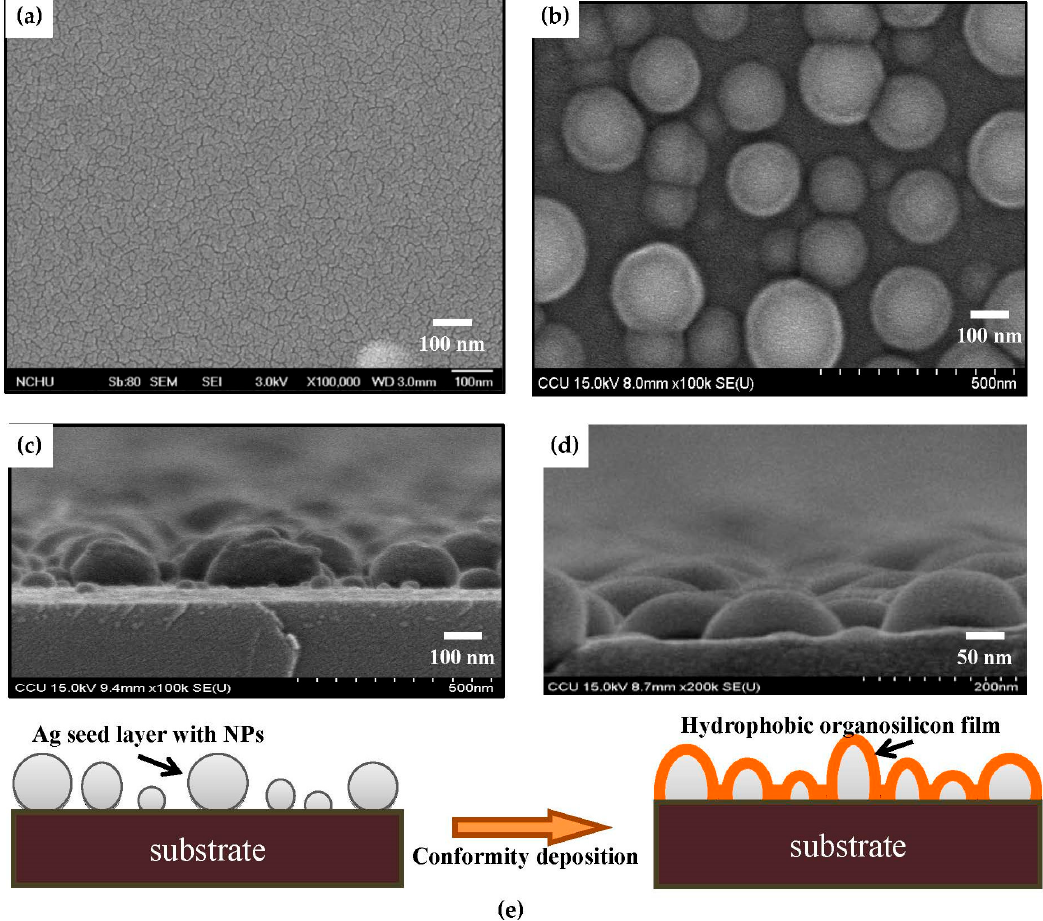
Figure 5. Topographical images by FE-SEM observations of the organosilicon films deposited onto: ( a ) the silicon substrate; and ( b ) the annealed Ag seed layer. Cross-section images by FE-SEM observations of: ( c ) the annealed Ag seed layer; and ( d ) the organosilicon film deposited onto the annealed Ag seed layer. ( e ) A schematic representation of the conformity deposition.